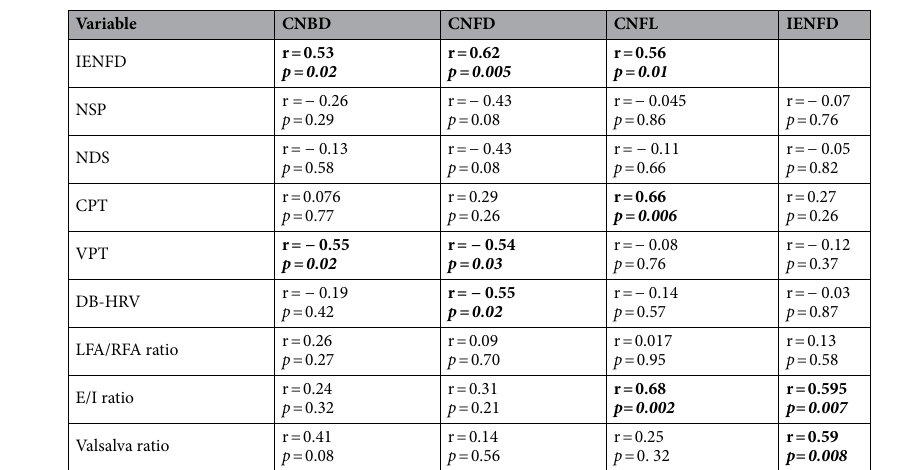
Table 3. Correlations between percentage change in small fibre pathology and other measures of diabetic neuropathy from baseline to follow up. NSP—neuropathy symptom profile, NDS—neuropathy disability